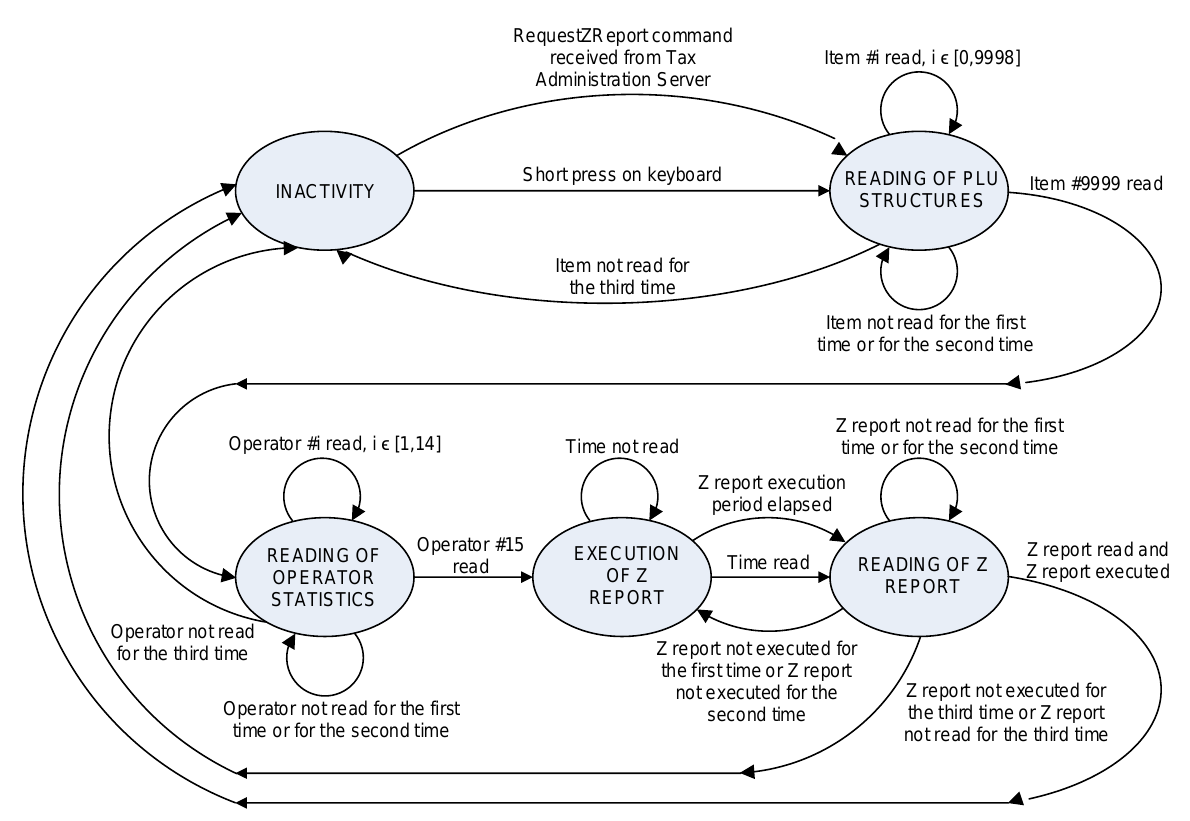
Figure 10. A state diagram of the complete Z report workflow.